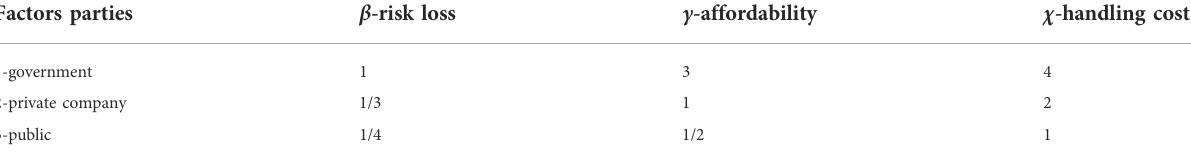
TABLE 5 Judgment matrix based on expert interviews. Factors parties